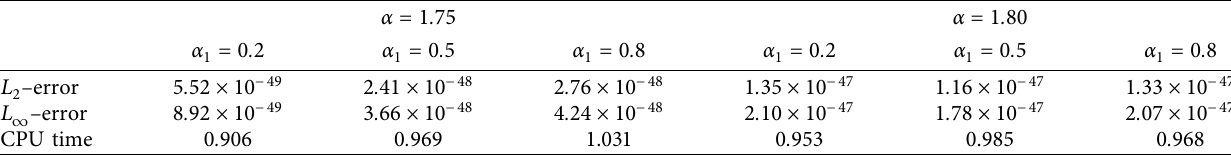
Table 2: L –error, L –error, and CPU time taking different values for α and α 2 ∞